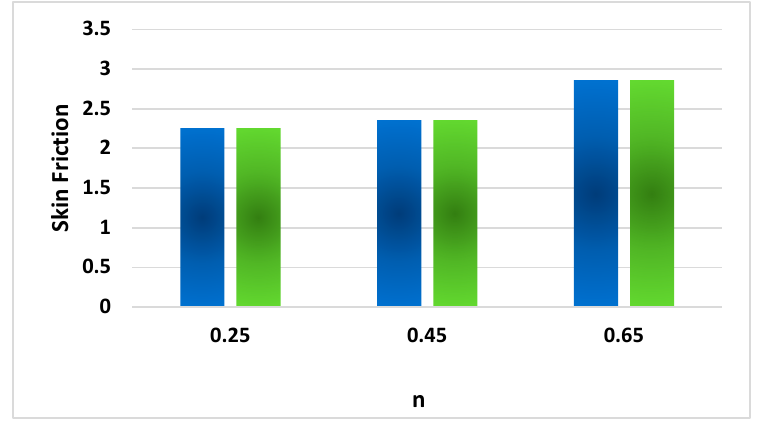
Figure 15. Revealing the consequences of n with the related skin friction coefficient.